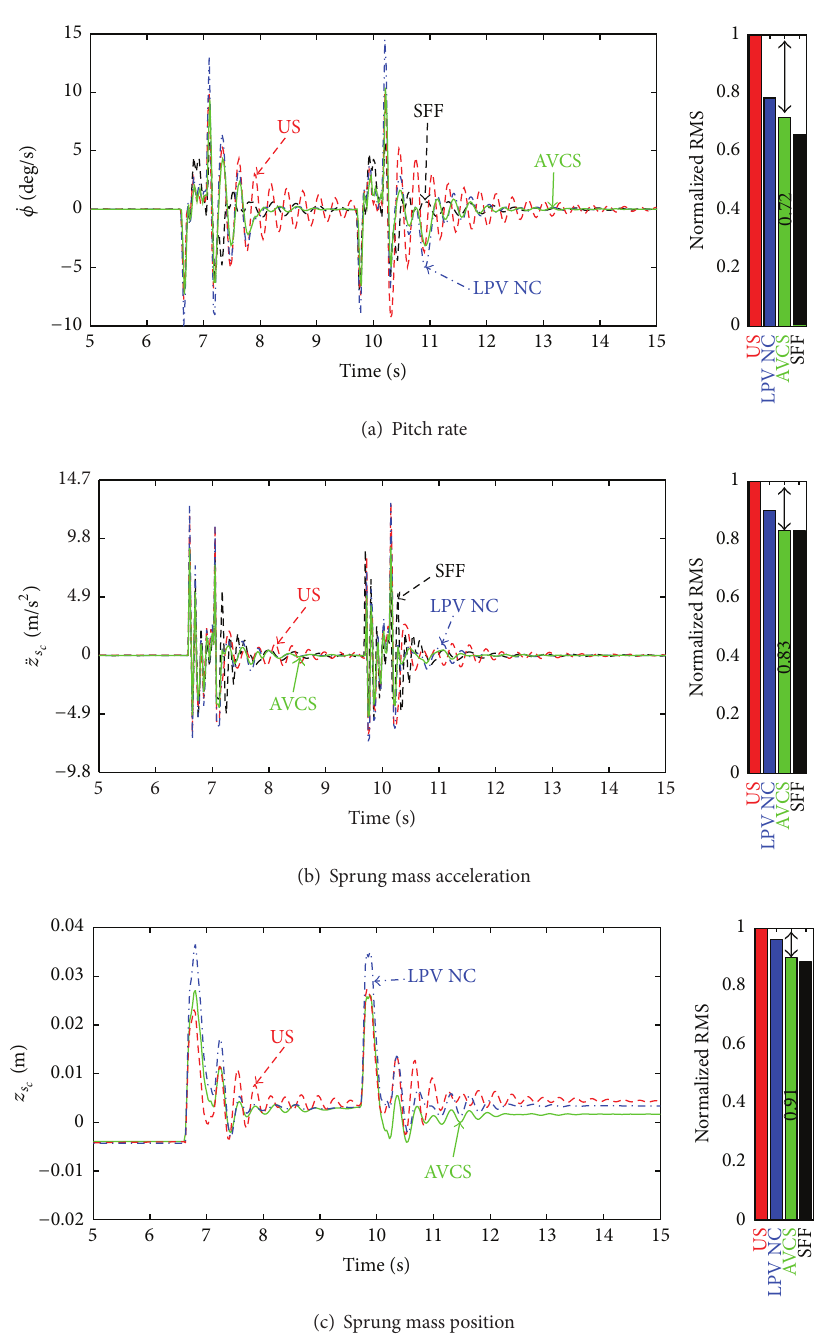
Figure 11: Performance of the AVCS and comparison with other suspension systems in test # 1 , by using a normalized RMS with respect to the uncontrolled